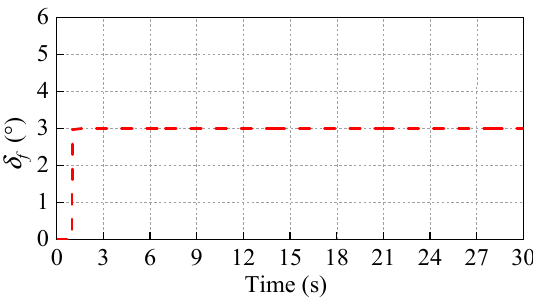
Figure 17. Step input of steering angle.